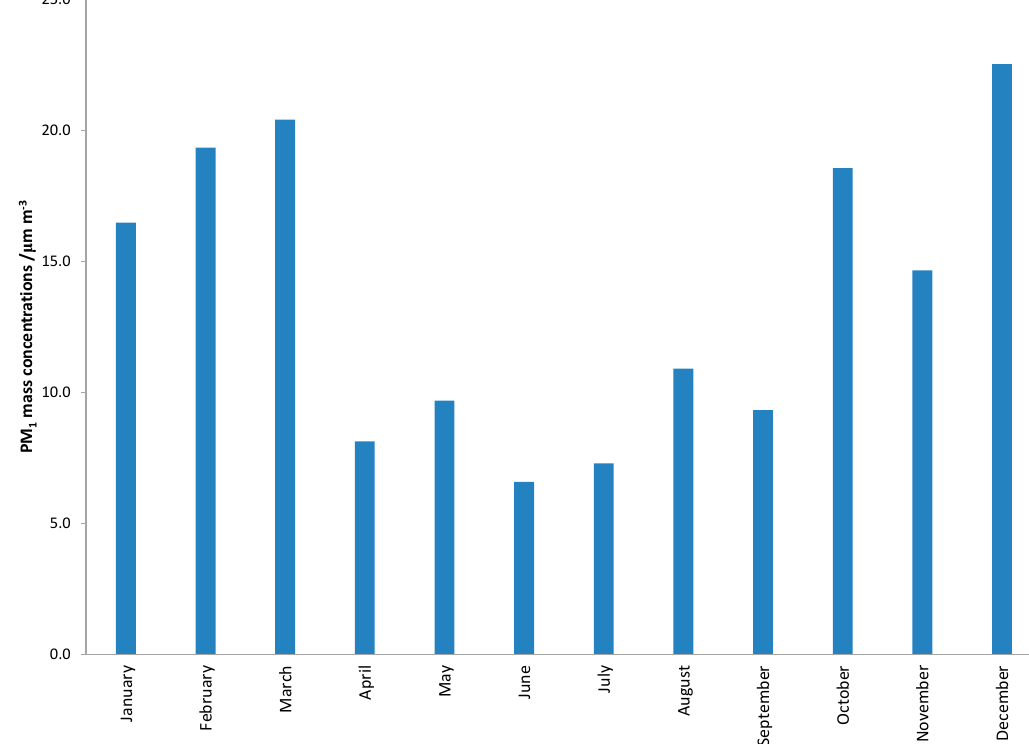
Figure 1. Monthly mass concentrations of the PM 1 particle fraction during one calendar